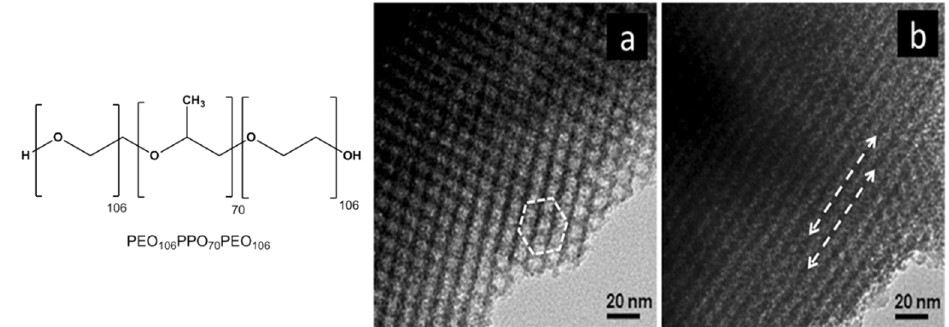
Figure 18. TEM images of mesoporous IrO 2 films template with PEO 106 PPO 70 PEO 106 recorded along the ( a ) [100] and ( b ) [110] axes of the 2D hexagonal structure (Reprinted/adapted with permission from Ref. [74]).